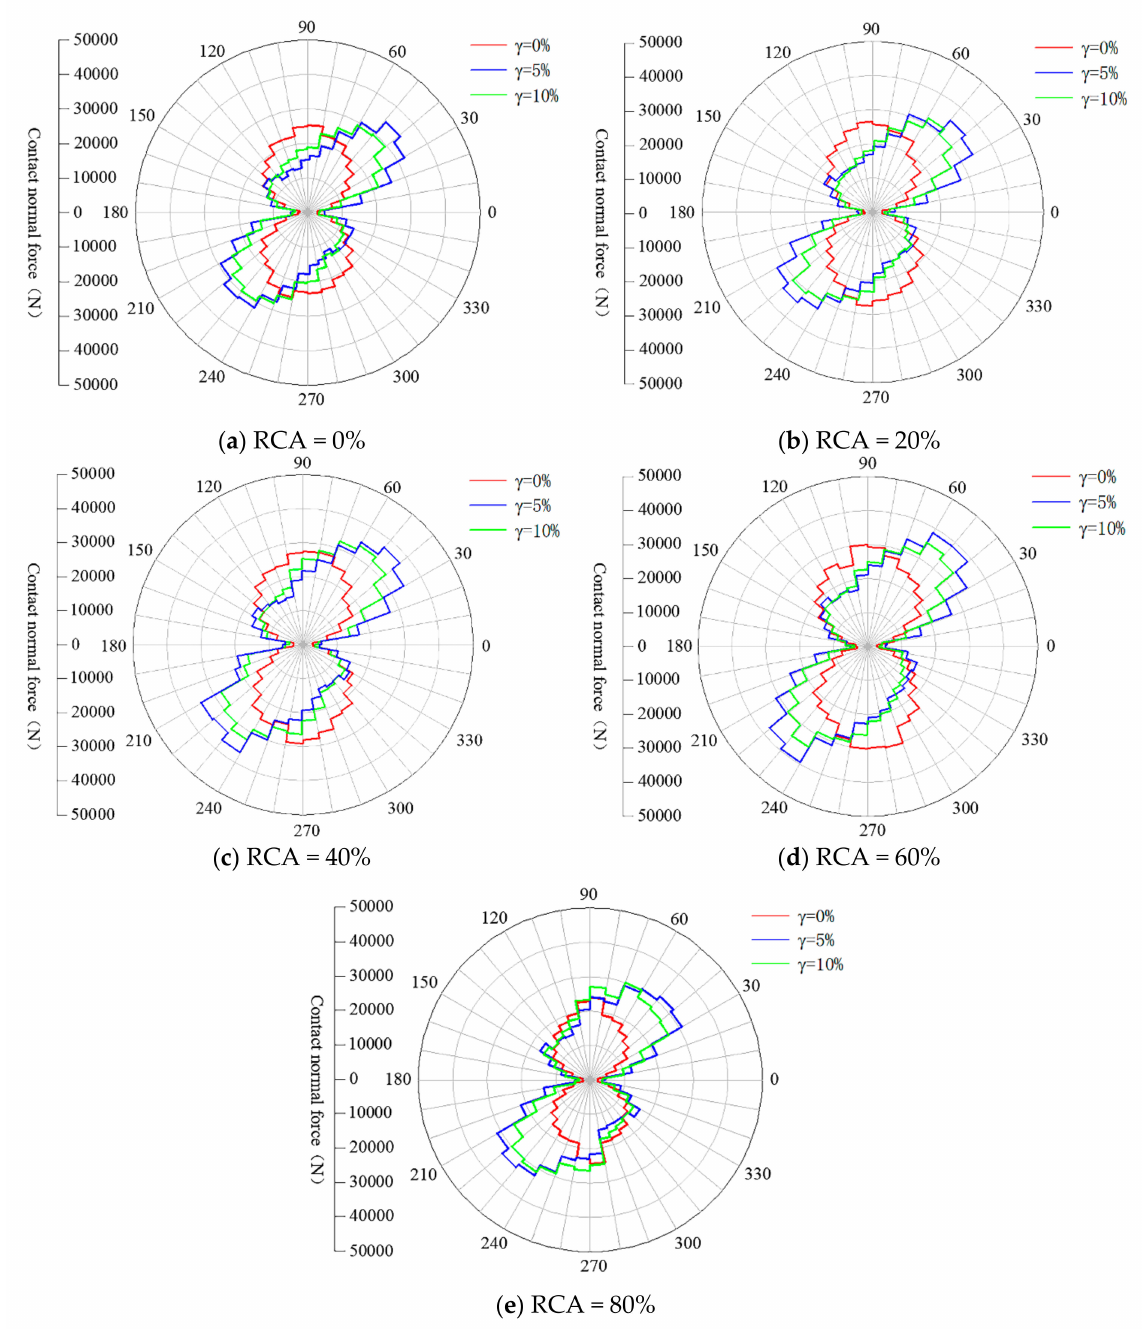
Figure 16. The anisotropies of normal contact force of samples with various RCA contents in different shear states: ( a ) RCA = 0%; ( b ) RCA = 20%; ( c ) RCA = 40%; ( d ) RCA = 60%; and ( e ) RCA =